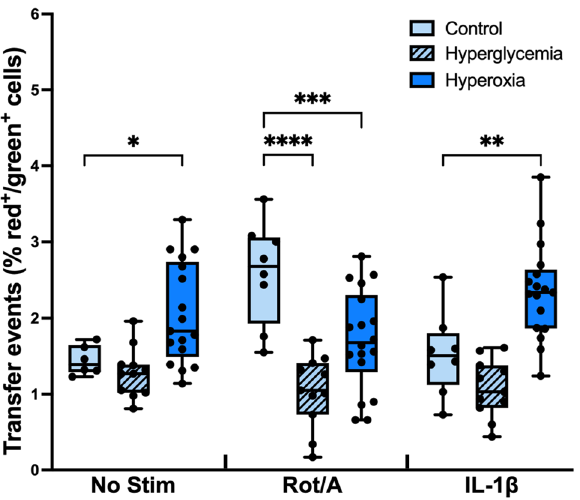
Figure 3. MSC-chondrocyte MT transfer is affected by non-physiologic culture conditions. Murine mCherry chondrocytes (red) and PhAM mitoDendra2 MSCs (green MT) were co-cultured in hyperoxia or hyperglycemia for 12 h after stimulation with or without Rot/A or IL-1β. MT transfer events (% red + /green + cells) were quantified by flow cytometry. Hyperoxia increases transfer events in non-stimulated and IL-1β-stimulated chondrocytes ( P < 0.05). Hyperoxia and hyperglycemia decreased transfer events when chondrocytes were stimulated with Rot/A ( P < 0.0007). n =